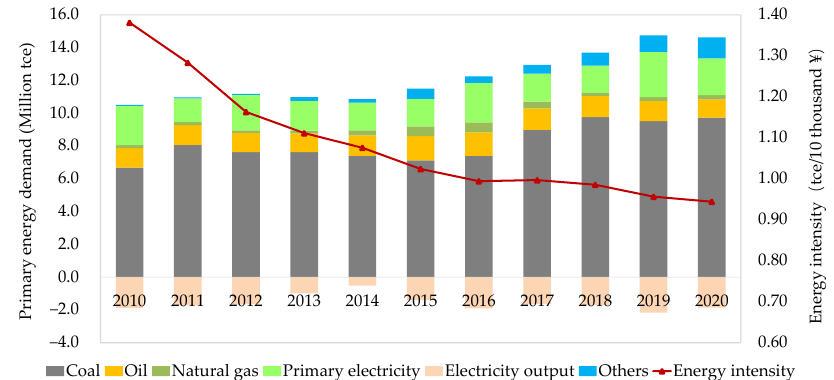
Figure 3. The primary energy demand and energy intensity from 2010 to 2020.